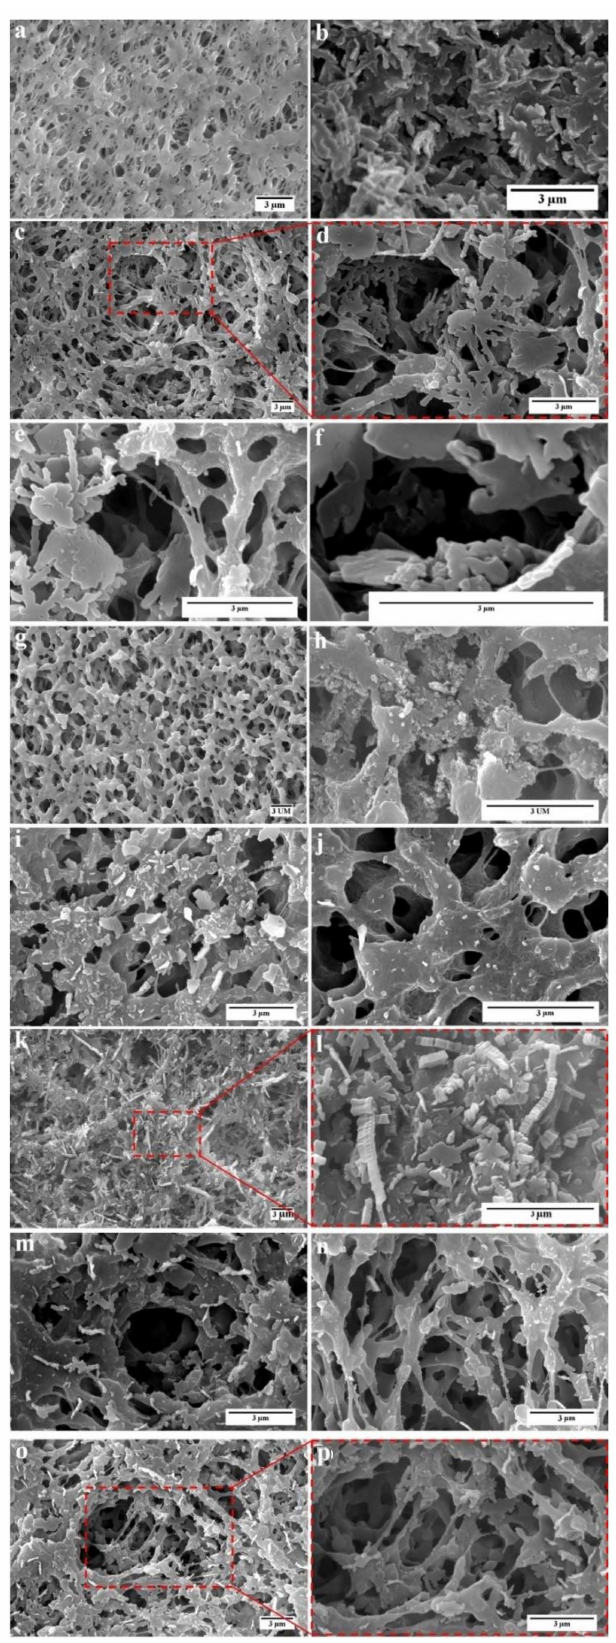
Figure 5. The FESEM images of ( a ) the virgin PVDF membrane; ( b – f ) the FTCS–TiO2–PVDF membrane at di ff erent magnifications; ( g , h ) the TiO2–PVDF membrane in di ff erent magnifications; ( i – p ) the FTCS–PVDF membrane in di ff erent